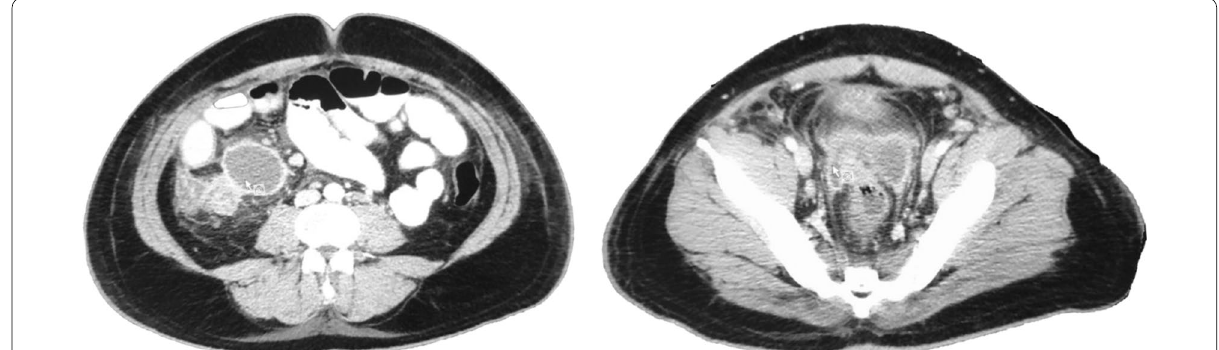
Fig. 2 Abdomino‑pelvic CT. Interloop edema, perivesical fluid infiltration and scant free fluid in the abdomino‑pelvic